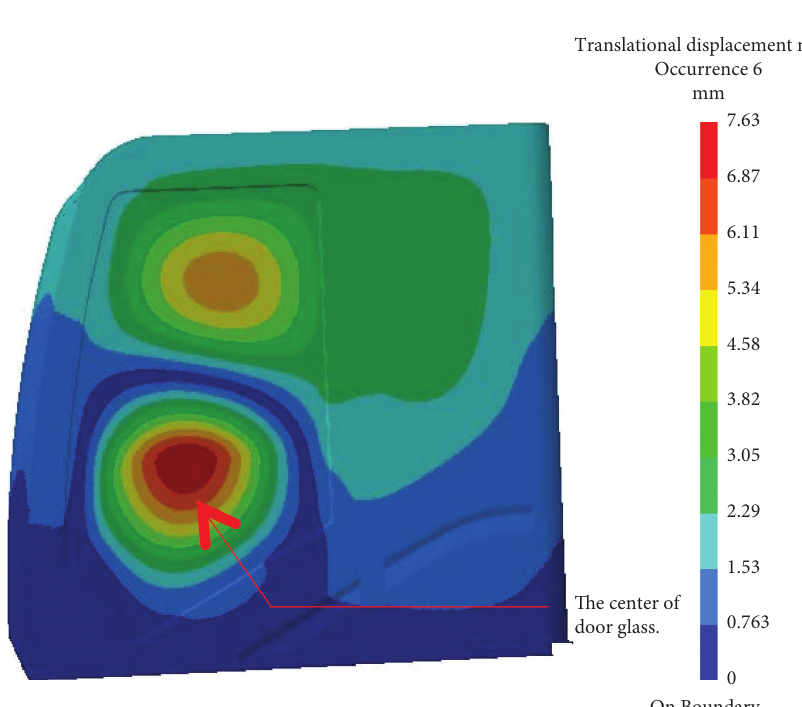
Figure 17: Sixth-order vibroacoustic coupling